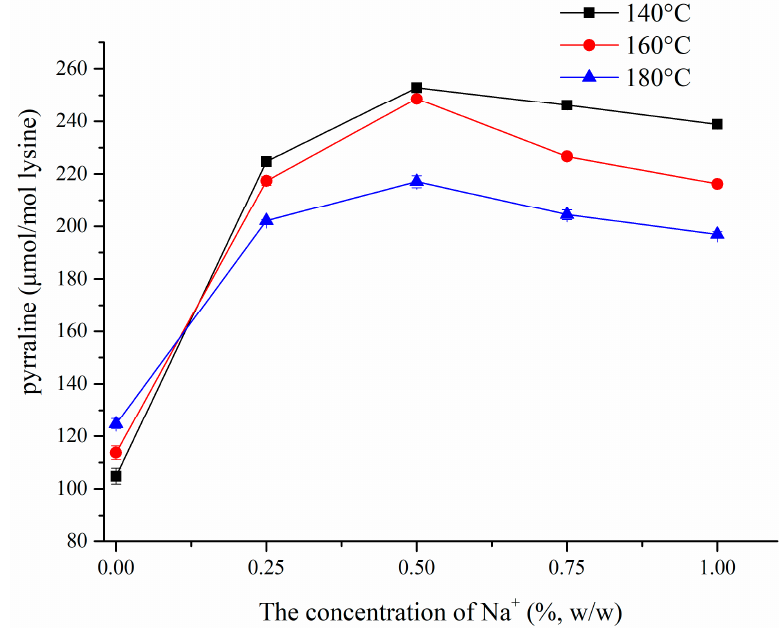
Figure 2. Sodium and temperature-dependent formation of pyrraline in model reaction systems.